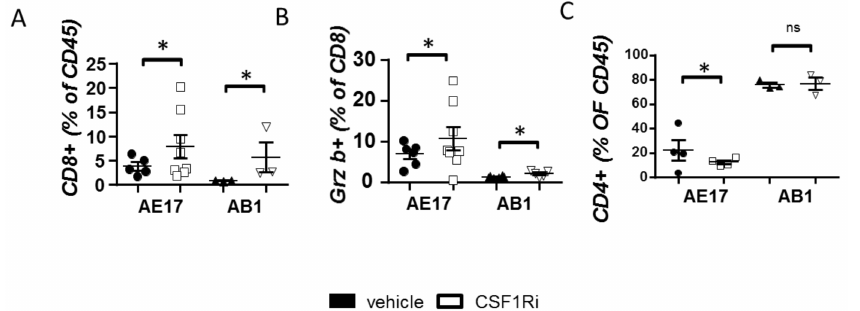
Figure 3. CSF1R inhibition enhances CD8 lymphocyte activation and recruitment and reduces T regulatory populations. Tumors of vehicle- and CSF1Ri-treated animals were analyzed for central T populations using flow cytometry. The total ( A ) and ( B ) activated (GranzymeB+) tumor CD8+ lymphocyte numbers were determined. ( C ) Suppressive (Foxp3+) CD4+ lymphocytes were also quantified. Data are presented as mean ± SEM, n = 5–8 from two independent experiments, * p < 0.05 compared to the vehicle by 2-tailed students’ t